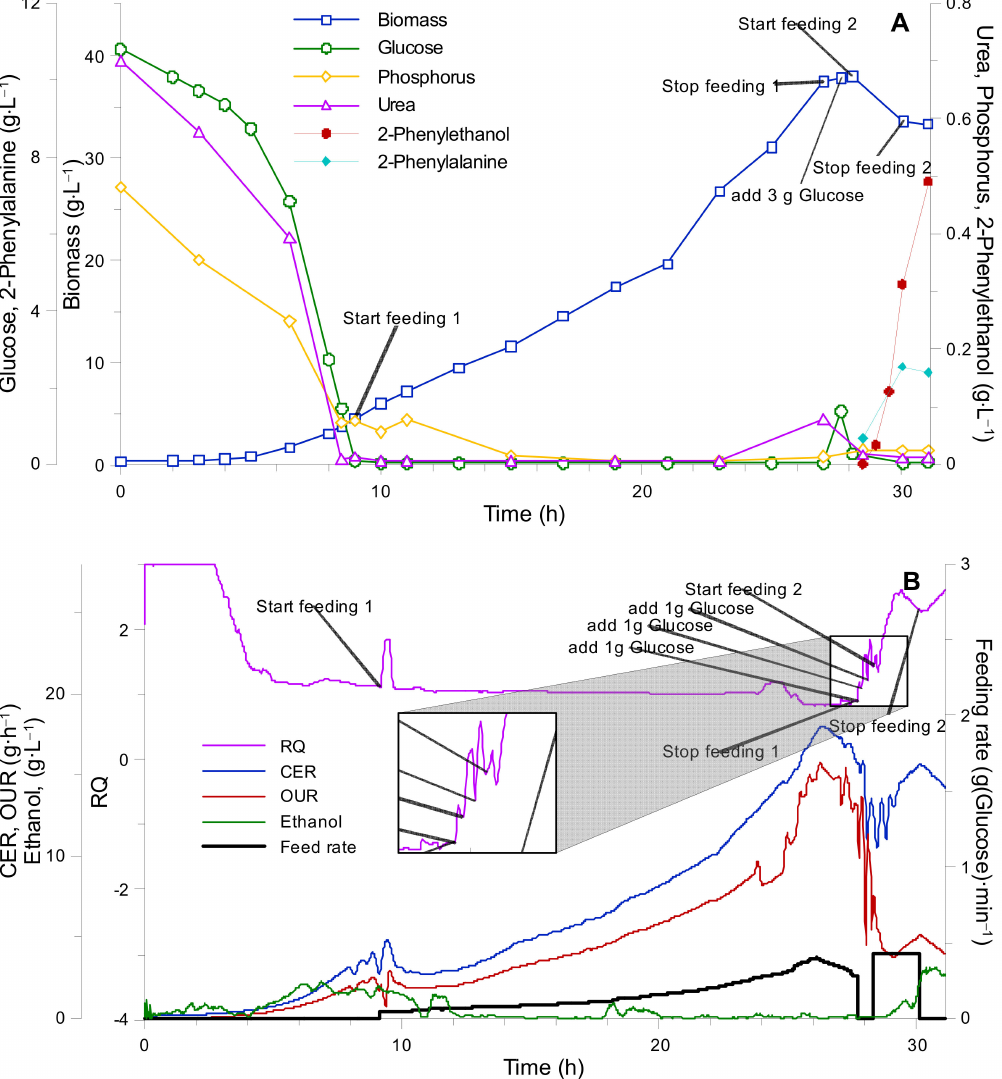
Figure 7. K. marxianus fourth bioreactor fed-batch cultivation. ( A ) Biomass growth and cultivation medium component (glucose, urea, phosphorus) uptake curves. ( B ) Gas analysis data (RQ—respiratory quotient, CER—carbon evolution rate, OUR—oxygen uptake rate, ethanol concentration, and feeding